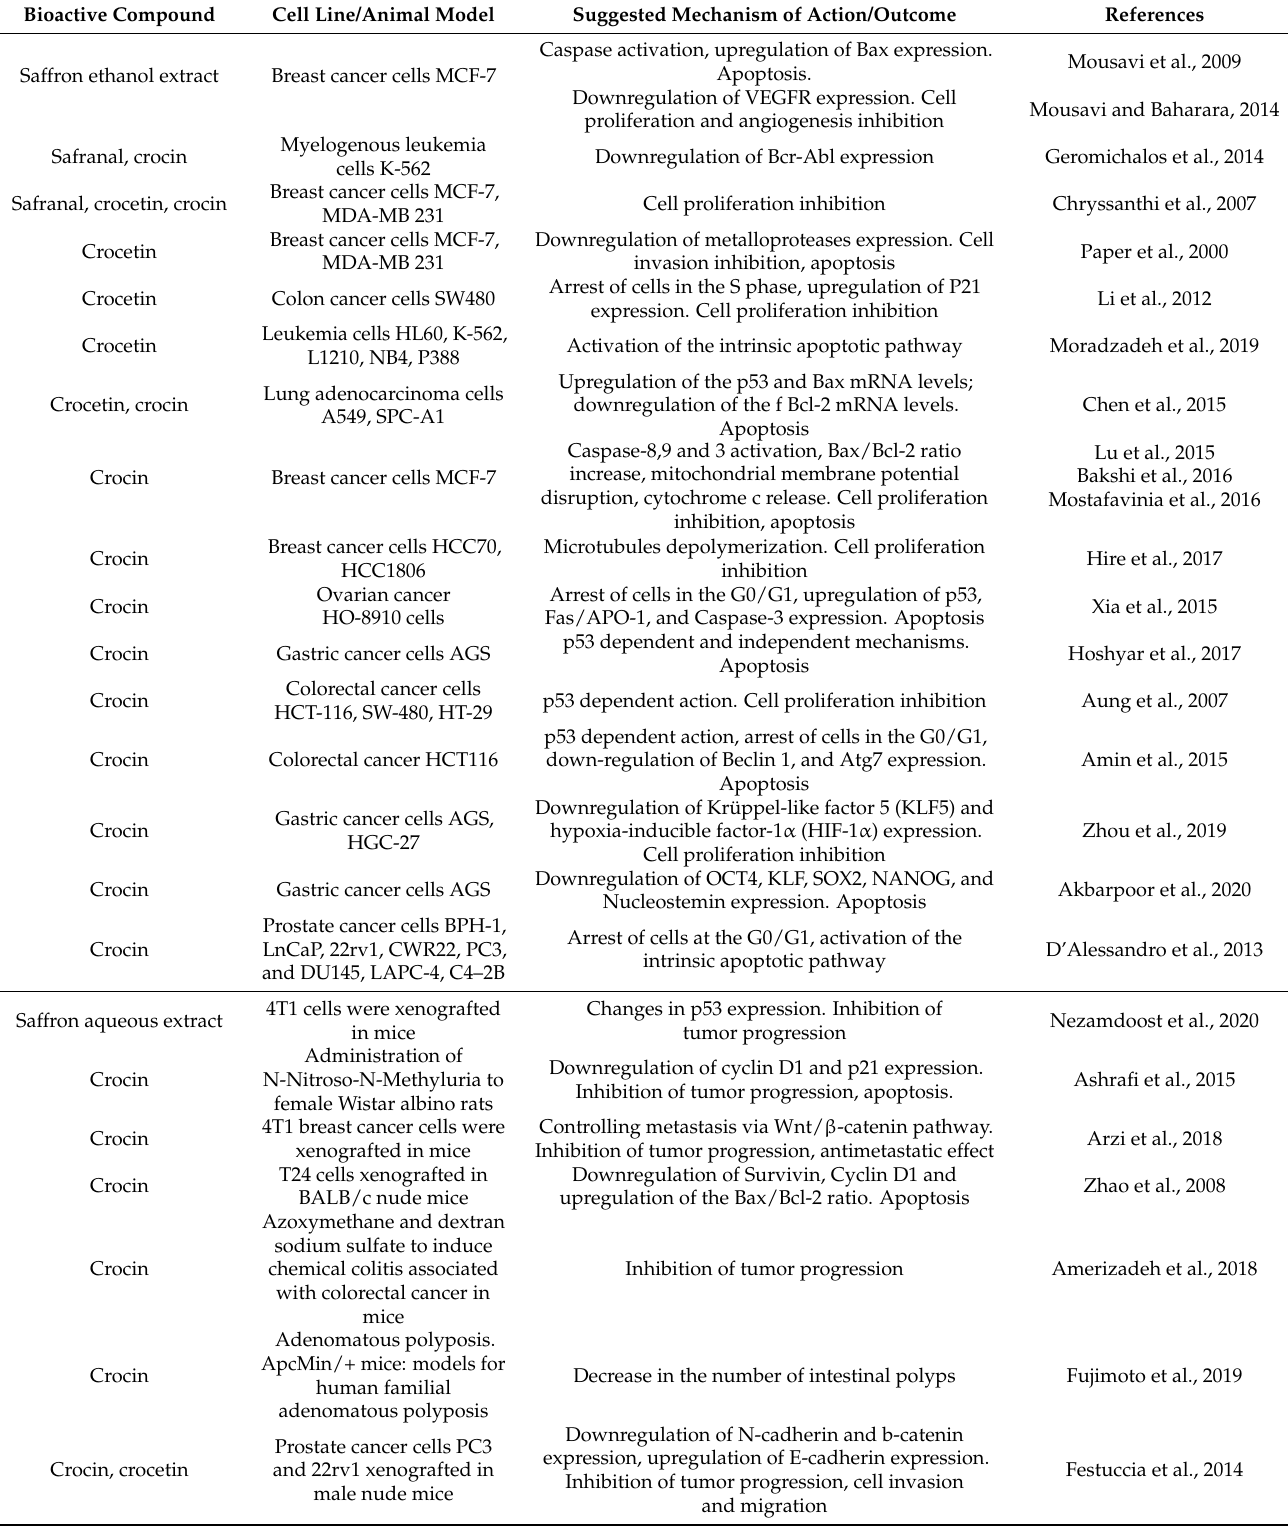
Table 1. Major studies on the anticancer effects of saffron extract and its major ingredients in cell lines and animal models of